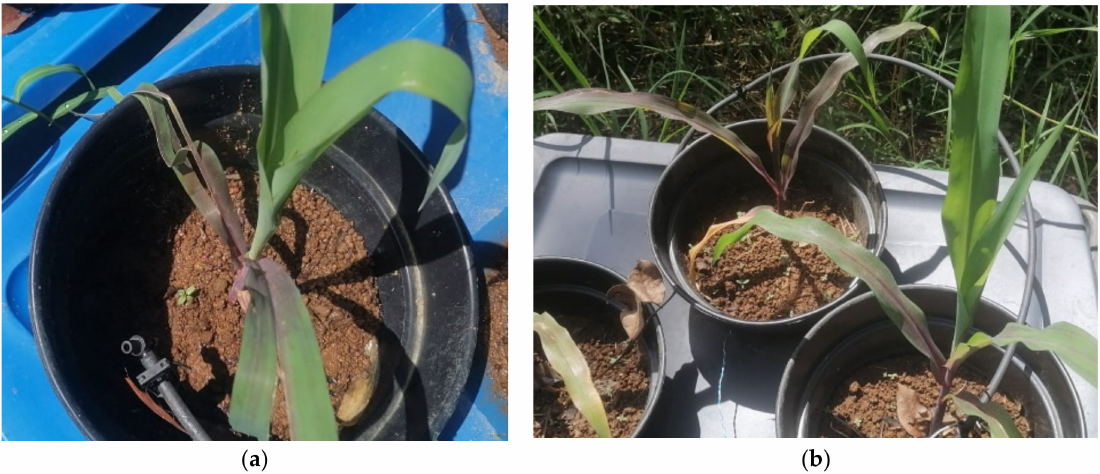
Figure 10. Leaves of plants grown with a concentration of lead of 1 g L − 1 , and a pH of: 5.5 ( a ), and 6.5 ( b ). A leaf discoloration is observed, a symptom due to the presence of lead. Data collected by the